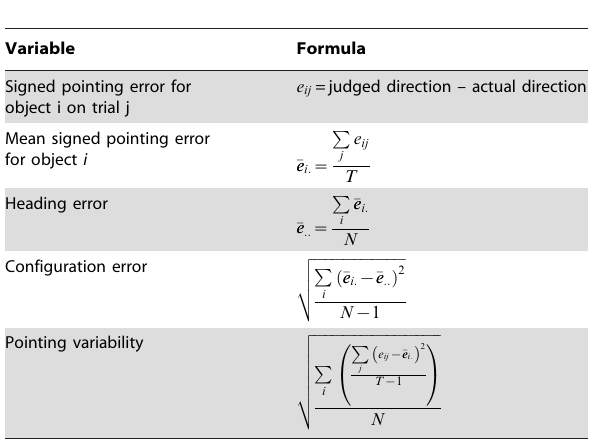
Table 1. Definitional Formulas for Dependent Variables.